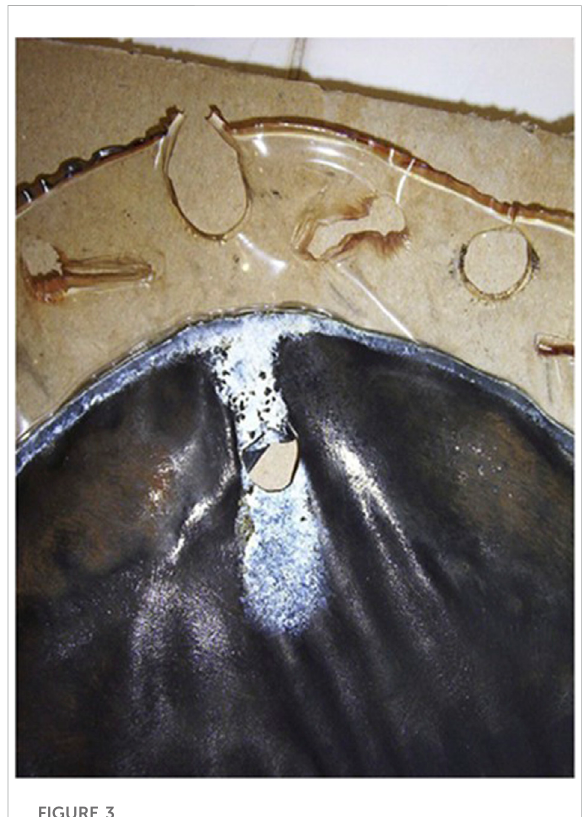
FIGURE 3 An extreme example of a hole present in a membrane post- operation. Reproduced with permission from Millet et al.